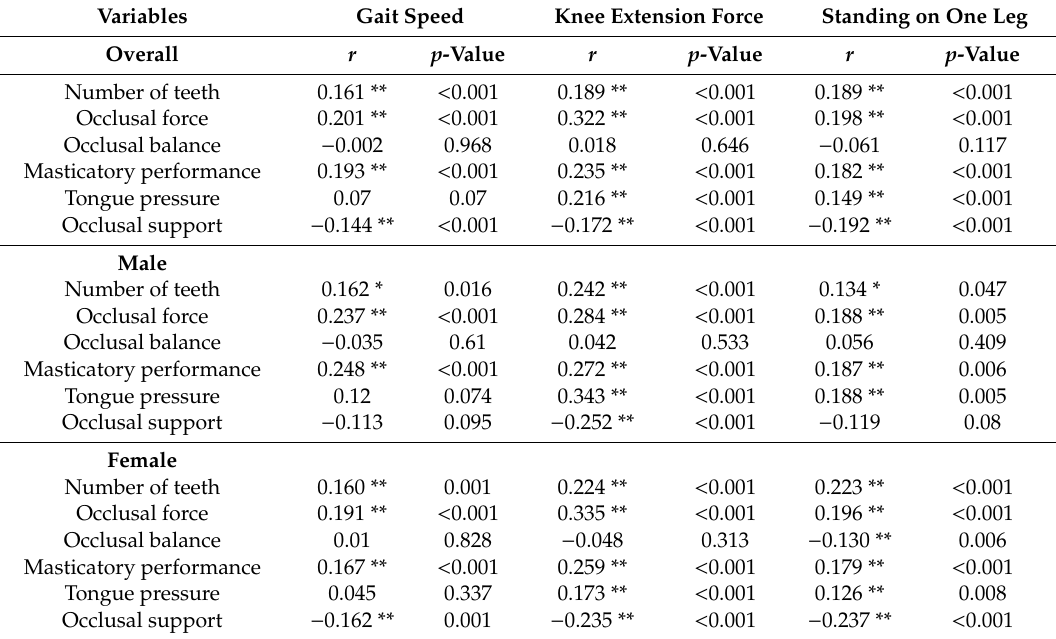
Table 2. Relationship between oral assessments and motor